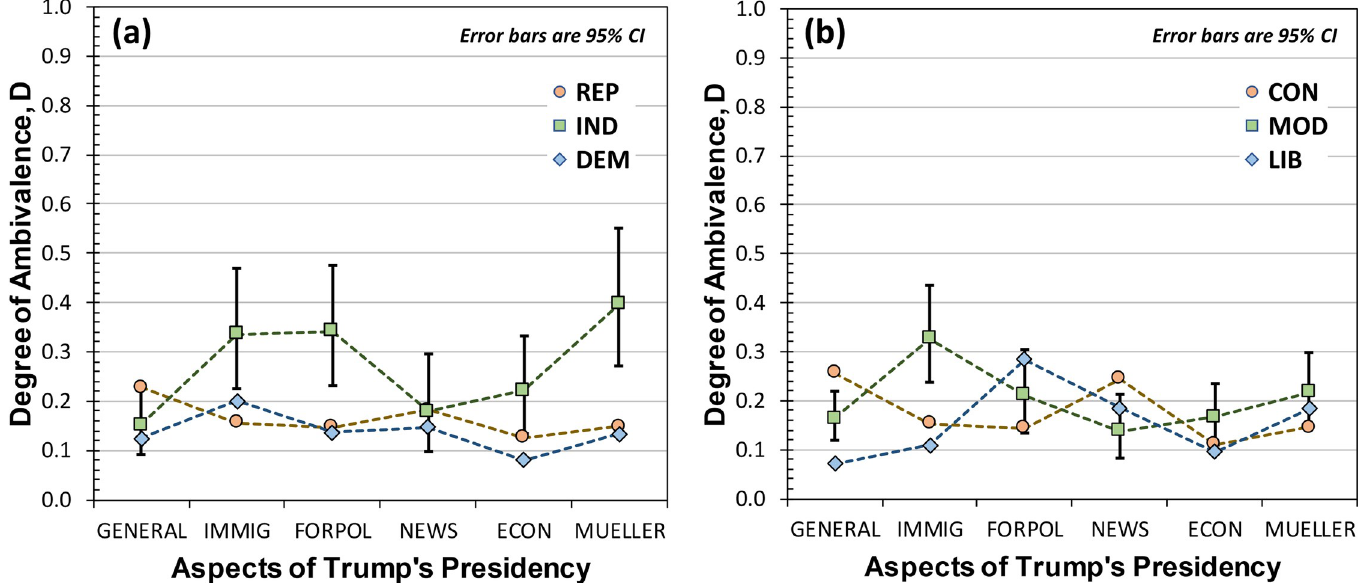
Fig 8. Degrees of ambivalence for various aspects of Trump’s presidency: GENERAL aspects of the presidency, immigration (IMMIG), Foreign Policy (FORPOL), interactions with the news media (NEWS), the economy (ECON), and the Mueller probe (MUELLER). (a) is for Republicans (REP), Independents (IND), and Democrats , (b) is for Conservatives (CON), Moderates (MOD), and Liberals (LIB). Median values and 95% CIs were determined by Markov Chain Monte Carlo for the probability distribution of Eq (10). For clarity in the graph, 95% CI error bars are only shown for INDs and MODs. Error bars for DEMs (LIBs) were somewhat smaller, while error bars for REPs (CONs) were